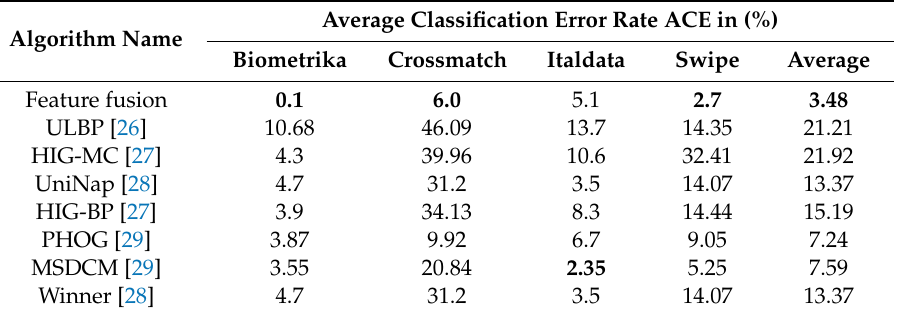
Table 10. The comparisons of the ACE of di ff erent algorithms in the LivDet 2013 dataset.